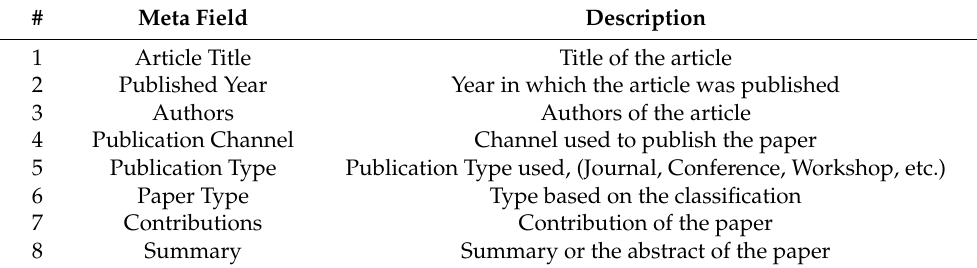
Table 2. Extracted metadata from the mapping process.